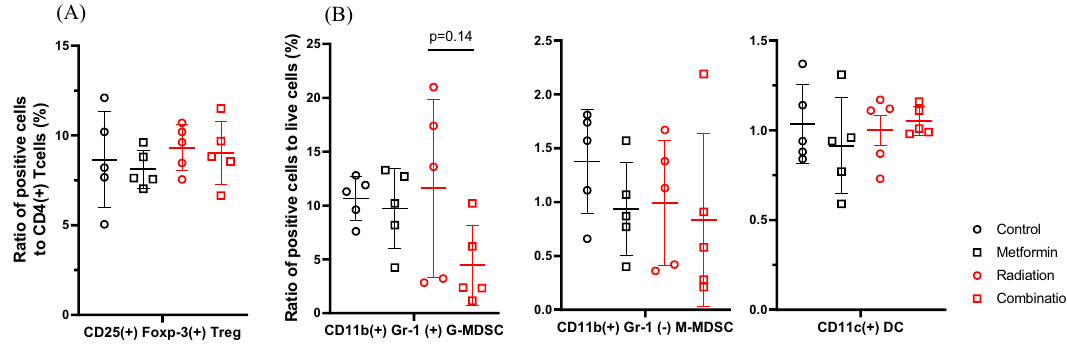
Figure 5. Splenocytes were harvested on day 28 and the frequencies of T-reg to CD4( +) T cell population ( A ) and CD11b(+)Gr-1(+) granulocytic-MDSC, CD11b( +)Gr-1(−) monocytic-MDSC as well as CD11c(+) DC in live cell gates ( B ) were determined with flow cytometry. Data are shown as mean ± standard deviation of 5 mice in one of the different 2